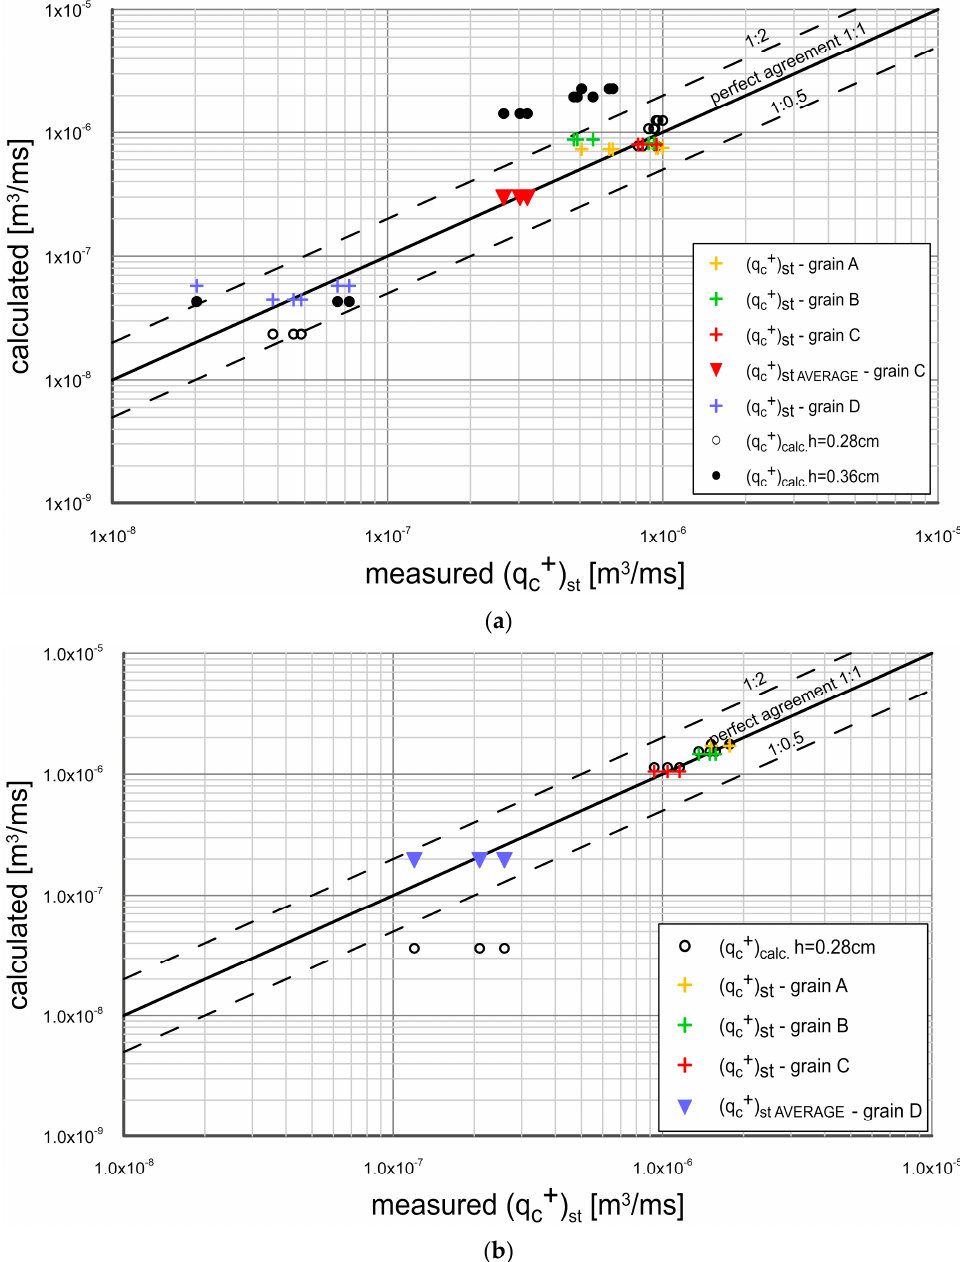
Figure 8. Comparison of calculation and measurements results q + c between flat ( a ) and sloped bed ( b ) cases during the crest.